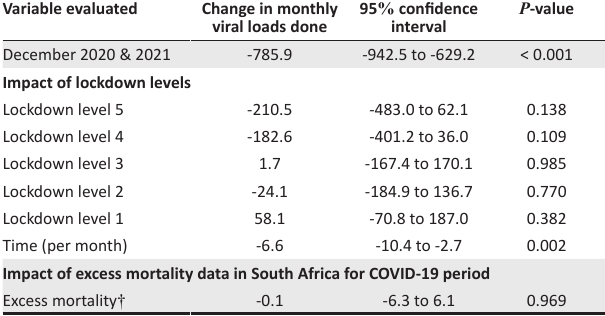
TABLE 2: Linear regression model of trends in monthly viral loads taken among all under-19s in eThekwini from January 2018 to January 2022. Variable